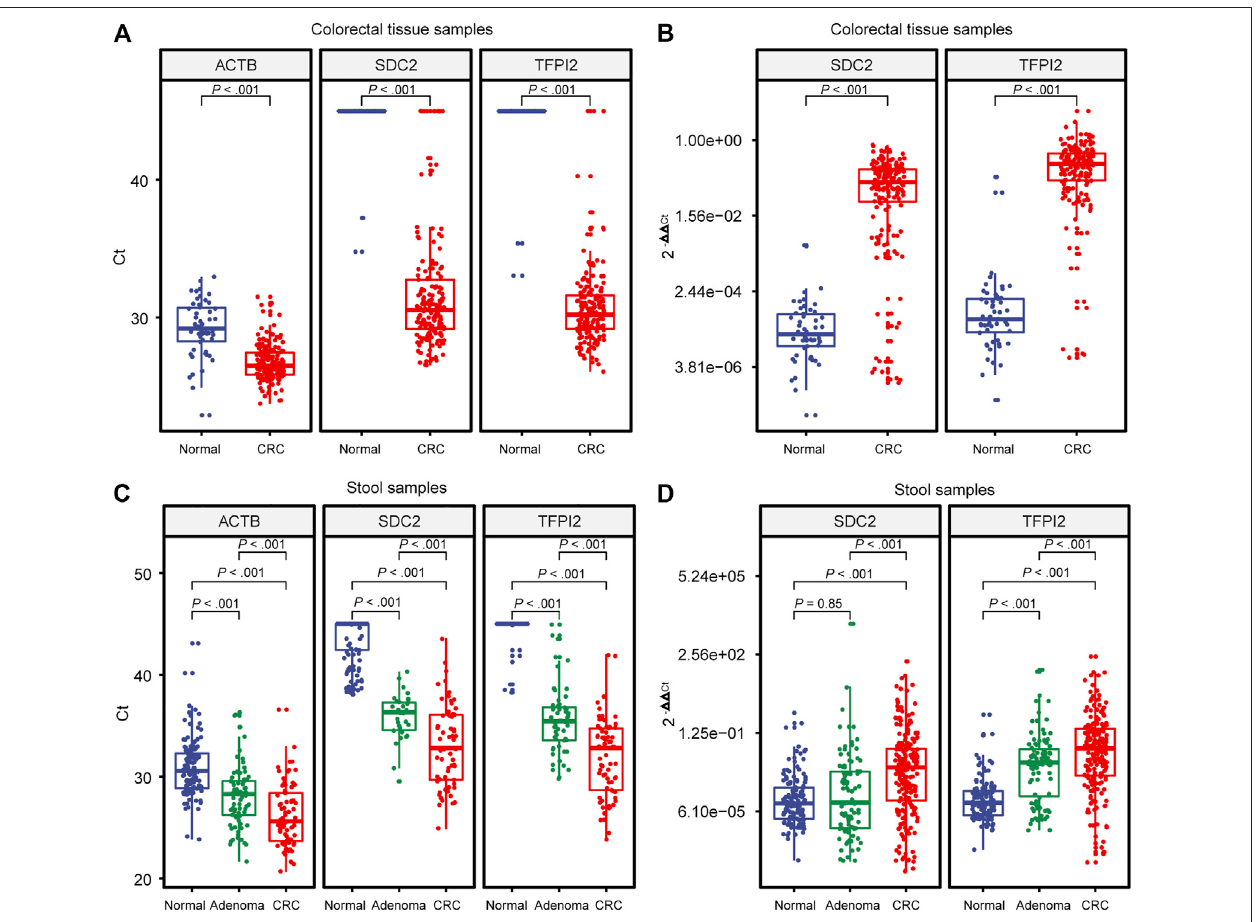
FIGURE 2 | Distribution of Ct and 2 − ΔΔ Ct values generated by MSP. (A) and (B) are built on colorectal tissue specimens. (C) and (D) are built on stool specimens. Each dot indicates an individual specimen. The extremes of the boxes de fi ne the upper and lower quartiles, and the center lines de fi ne the median. Whiskers indicate 1.5 × interquartile range (IQR). Beyond IQR are de fi ned the outliers. Statistically signi fi cant differences were determined using the Mann – Whitney U test, with a signi fi cant level of p < 0.05 and a highly signi fi cant level of p <